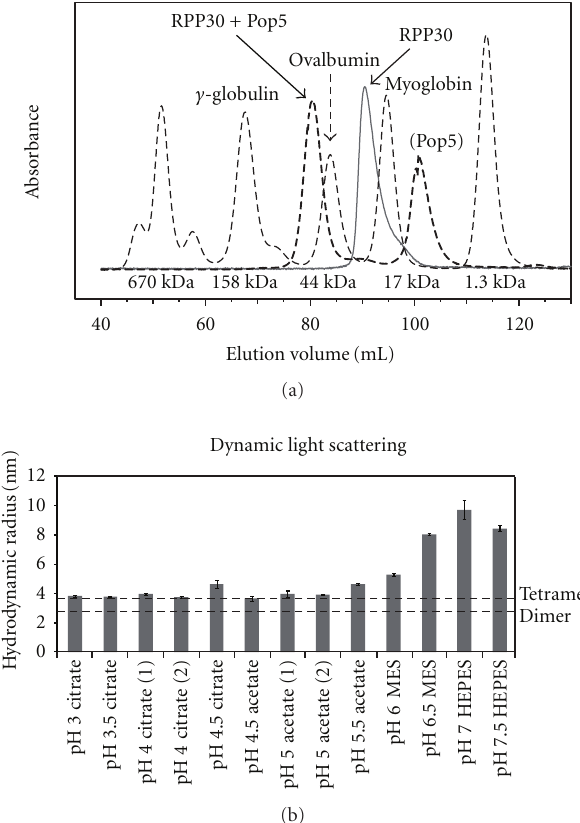
Figure 2: Size exclusion chromatography and dynamic light scatter- ing of the Pop5-RPP30 complex. (a) Gel filtration chromatogram of RPP30 alone (solid), RPP30 in the presence of excess Pop5 (dashed), and molecular weight standards (dotted; thyroglobulin (670kDa), γ -globulin (158 kDa), ovalbumin (44kDa), myoglobin (17kDa), and vitamin B 12 (1.3kDa)). The mixture of RPP30 with excess Pop5 yielded one peak corresponding to free Pop5, and a second peak with an apparent mass in excess of that expected for a Pop5-RPP30 heterodimer (39kDa). (b) Measured hydrodynamic radii of the Pop5-RPP30 complex from dynamic light scattering under varying bu ff er conditions. The dotted lines indicate the calculated hydrodynamic radii from HYDROPRO [18] for both a heterotetramer or a heterodimer. The smallest hydrodynamic radius is consistent with formation of a heterotetramer [(Pop5-RPP30) 2 , 3.65